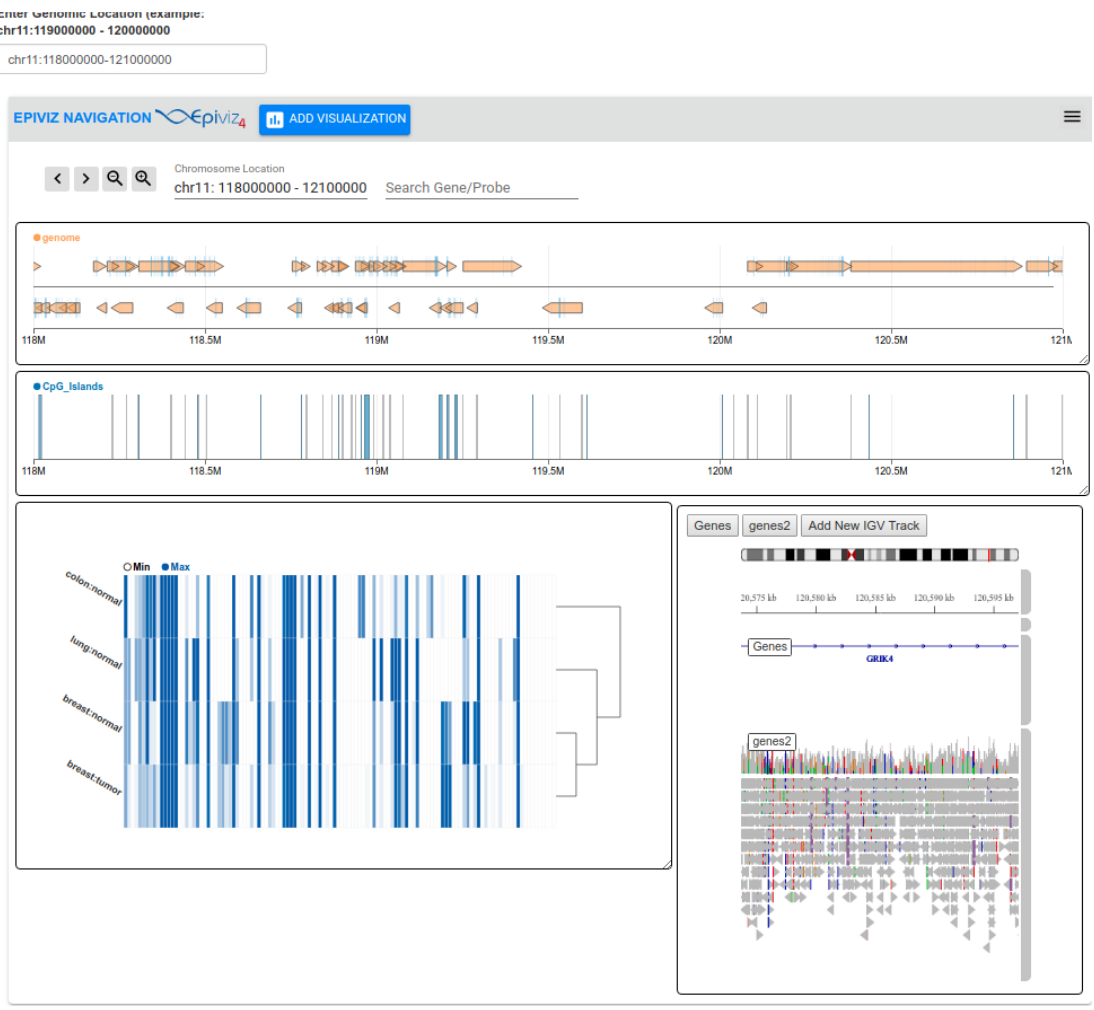
Figure 5. Interactive visualization of R/Bioconductor data objects in Shiny. In this Shiny application, we explore gene expression from the Gene Expression Barcode Project 11 for colon, lung and breast tissues for tumor and normal samples as a heatmap. We visualize annotation tracks for the genes and position of CpG islands in the current region. We also integrated IGV with epiviz components and the igv track (bottom right) displays the gene position and the aligned illumina reads for HG01879 sample from 1000 genomes 12 project. The IGV track queries the file directly to get data and visualize the reads. We also have a genomic location text box (top left) that is a non-epiviz component and can be used to interact with epiviz components within the Shiny application. Changing the location, updates the genomic region in the navigation element and all